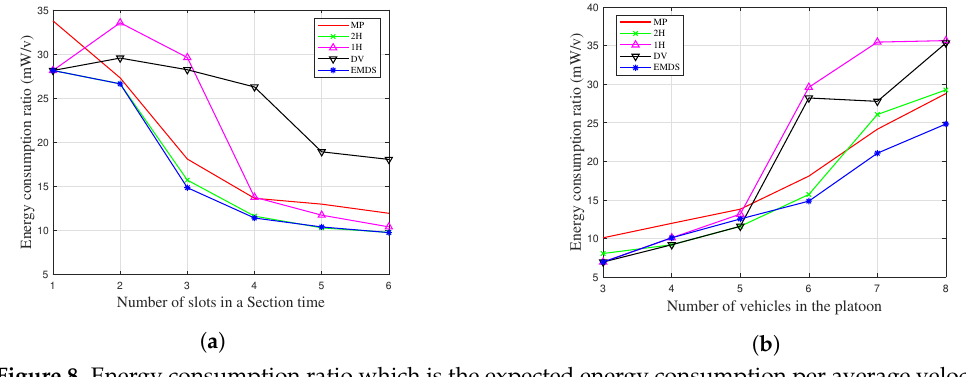
Figure 8. Energy consumption ratio which is the expected energy consumption per average velocity level of the platoon when α = 0.95; ( a ) A platoon with six vehicles varying the number of slots ( M ) in a section time and ( b ) Three slots in a section time varying the number of vehicles ( N ) in the